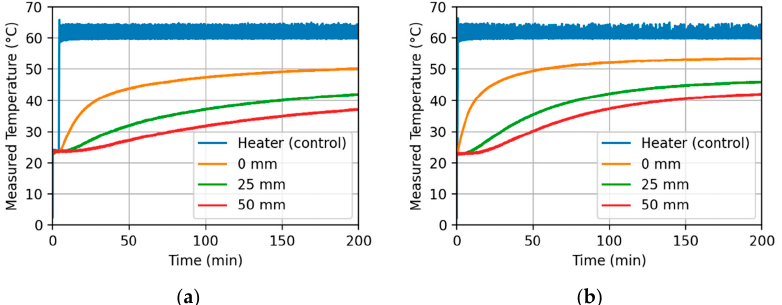
Figure 18. Temperature gradient measurements. ( a ) Chamber loosely packed with rPET; ( b ) chamber loosely packed with rPET, plus a metal cylinder, referred to as a heat sink. The measured temperature gradients while using the inside (0 mm) thermistor to drive the controller are shown in Figure 19. With no material in the chamber, the heater had to maintain an average temperature of 79 °C to keep the inside surface of the chamber at 60 °C. Note that the chamber was open to atmospheric air, allowing convective heat